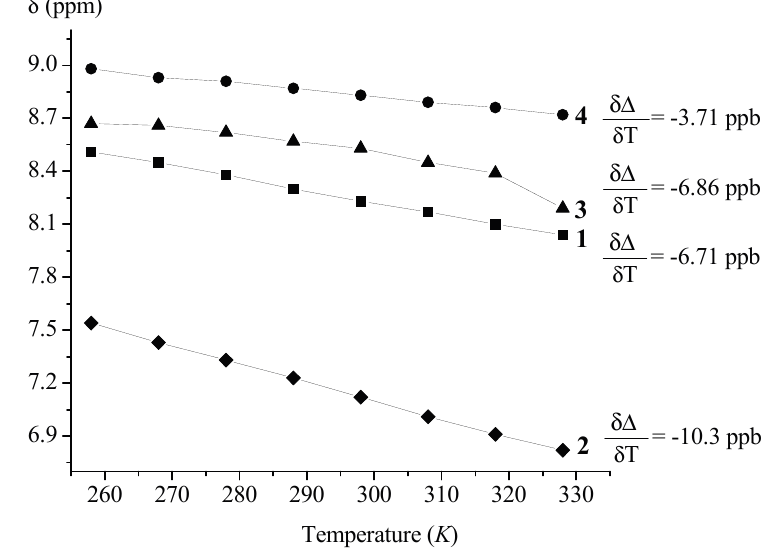
Figure 3. Temperature dependent NH in the temperature range of 258–328